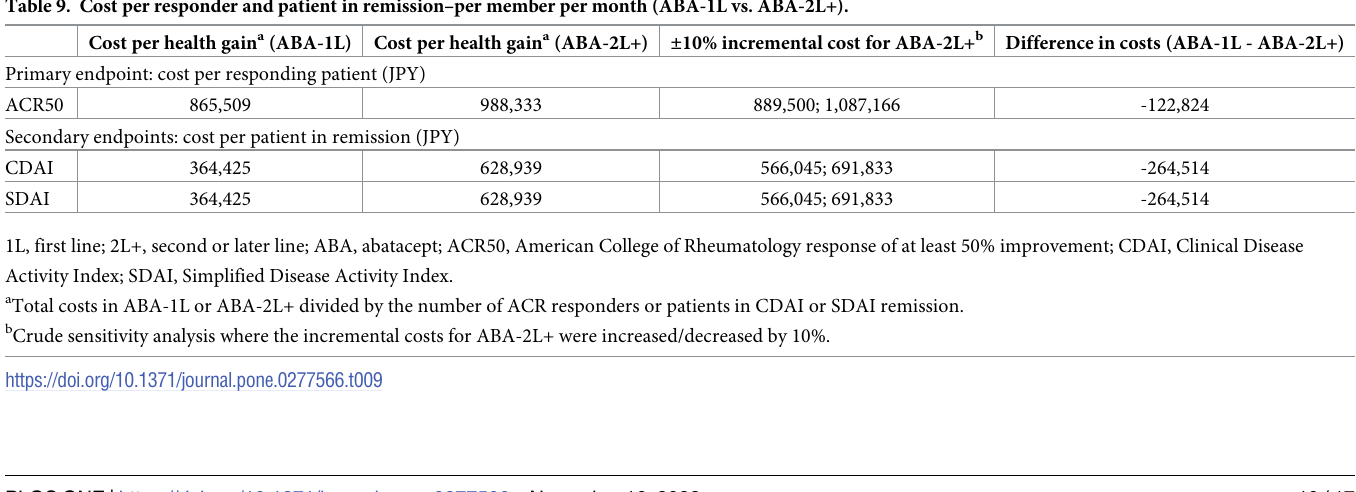
for all resources, except for the cost for bDMARDs that was -435 JPY (-4.1 USD) PMPM (Table 8). Across primary and secondary endpoints, costs per health gain were lower in ABA- 1L, with the incremental costs per ACR50 responder, CDAI remission and SDAI remission for ABA-1L versus ABA-2L+ being -122,824 JPY (-1,150 USD), -264,514 JPY (-2,477 USD) and -264,514 JPY (-2,477 USD), respectively (Table 9). Incremental costs per additional patient in CDAI and SDAI remission and with ACR50 response for ABA-1L were lower than -10% of those for ABA-2L+.